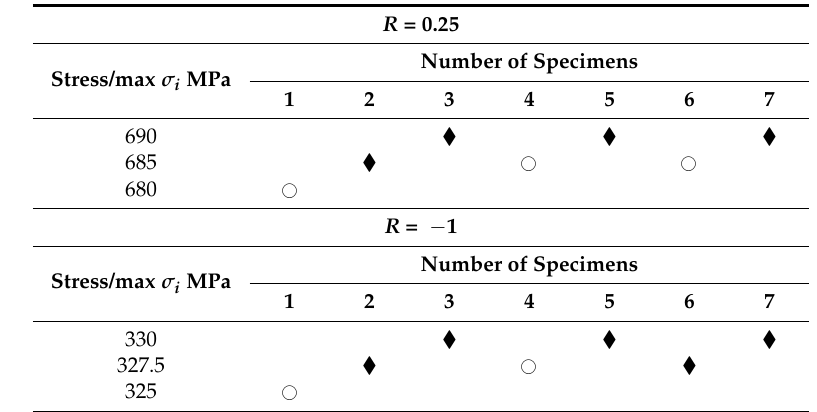
Table 4. Data for the modified staircase method related to failed ( (cid:7) ) and non-failed ( obtained from the fatigue tests.